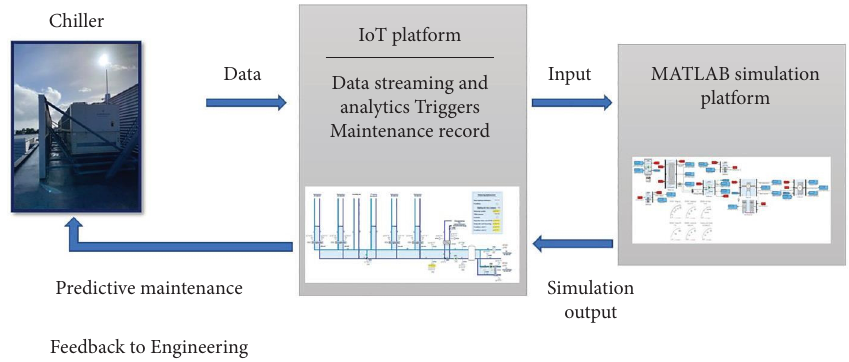
Figure 11: Digital Twin predictive maintenance framework of a